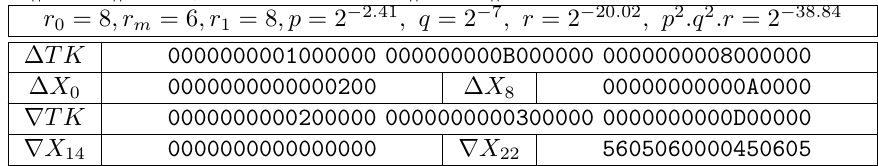
Table 11: Specification of boomerang distinguisher I for 22 rounds of SKINNY -64-192. ∆ TK =